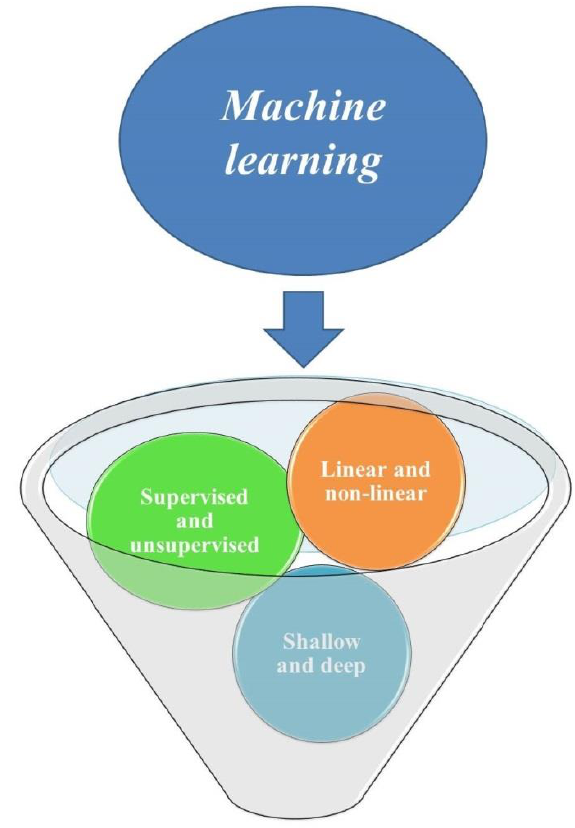
Figure 1. Different categories of machine learning algorithms. Figure 1. Di ff erent categories of machine learning